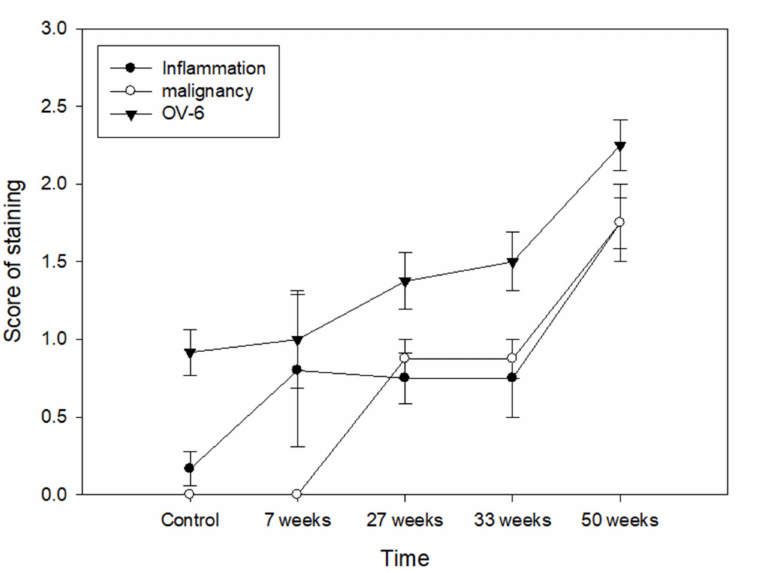
Figure 4. Correlation between malignant transformation, cancer stem cells and inflammation. p value was calculated by Spearman’s correlation